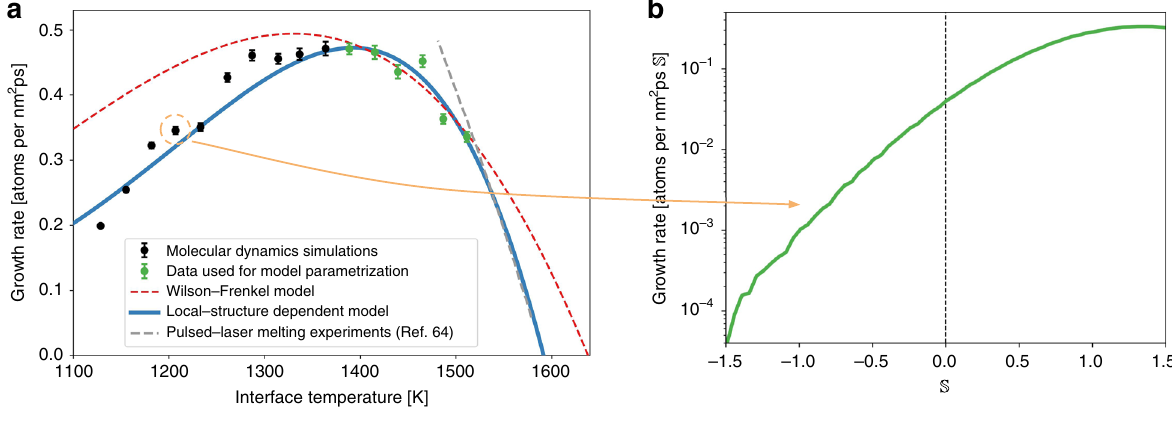
Fig. 3 Local-structure dependent crystal growth model. a Crystal growth rate of silicon versus interface temperature. Both models (Wilson – Frenkel and local-structure dependent model) were parametrized using only the data from simulations at T ≥ 1388K. Notice that the growth rate is given per unit of effective area of the total crystallite (see Supplementary Note 4) and the error bar represents the 95% con fi dence interval around the mean (see “ Methods ” section). Data for laser-pulsed melting experiments was extracted from Galvin et al. 64 . b Growth rate at T ≈ 1233K decomposed as a function of the local structure, as encoded by S , surrounding crystallizing atoms. Notice that the growth rate varies almost four orders of magnitude as S